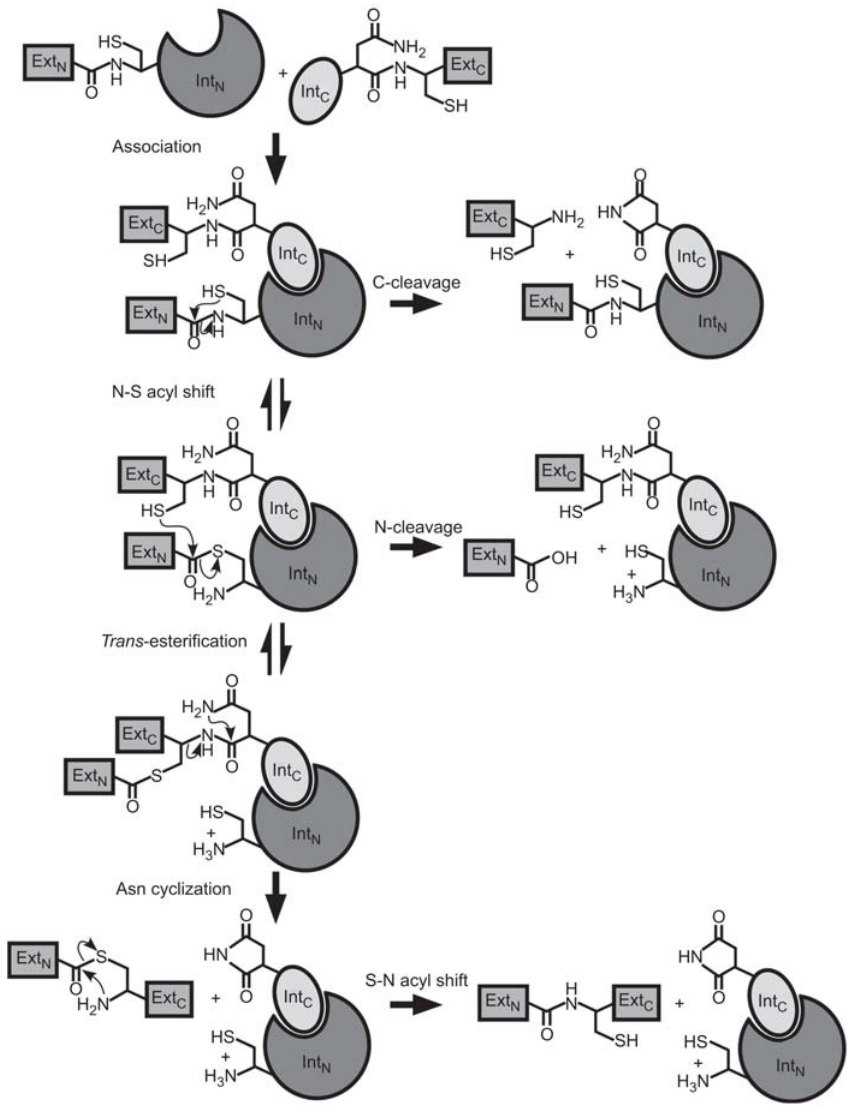
Figure 4 Schematic illustration of the mechanism of protein trans -splicing and cleavage reactions. Ext and Ext stand for N- and C-exteins, Int N C